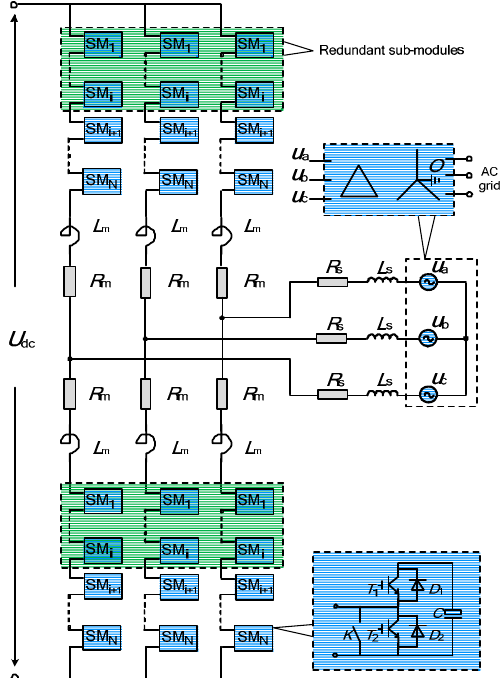
Figure 1. Topology structure of three-phase modular multilevel converter (MMC).